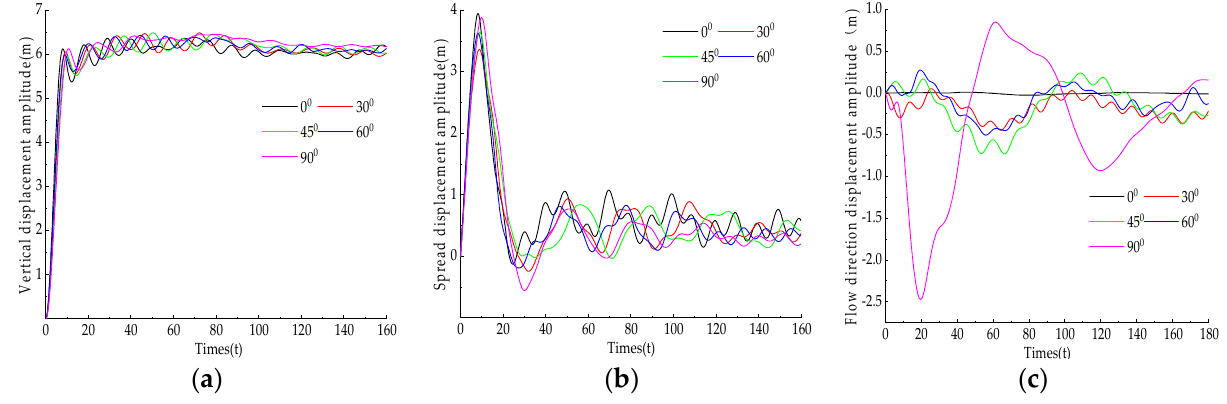
Figure 10. Time course curve of rigid body displacement under different incident rule waves. ( a ) Pendulum response curve; ( b ) Transverse rocking response curve; ( c ) Longitudinal rocking re- sponse curve.